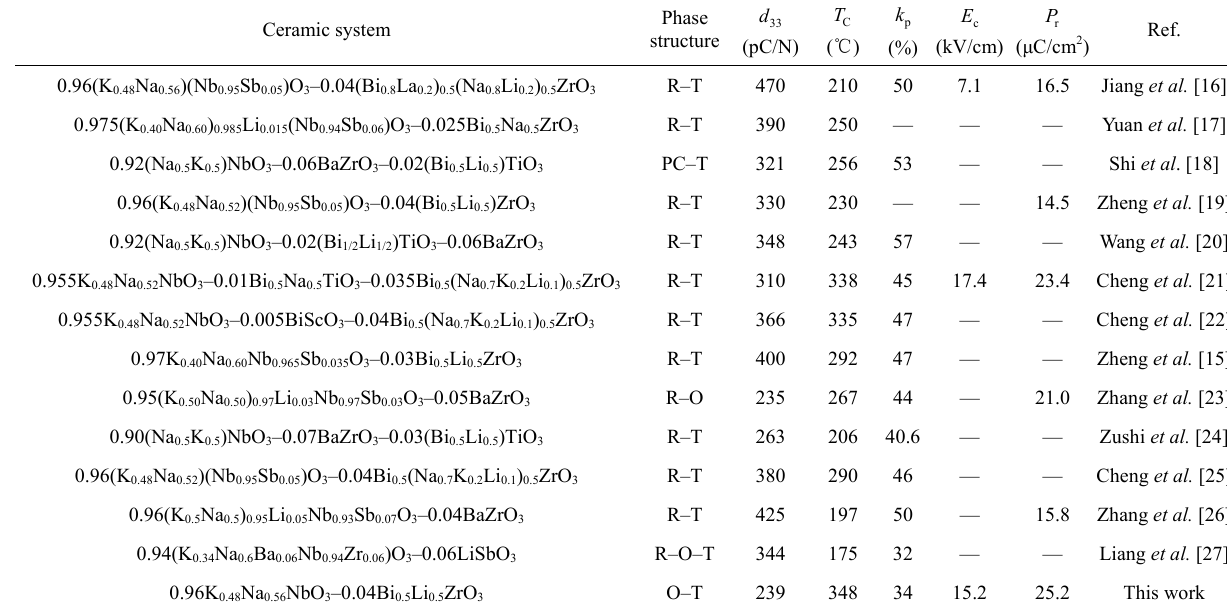
Table 1 Phase structure and electrical properties of Bi 3+ (or Ba 2+ ), Li + , and Zr 4+ doped KNN lead-free piezoelectric ceramics Phase Ceramic system